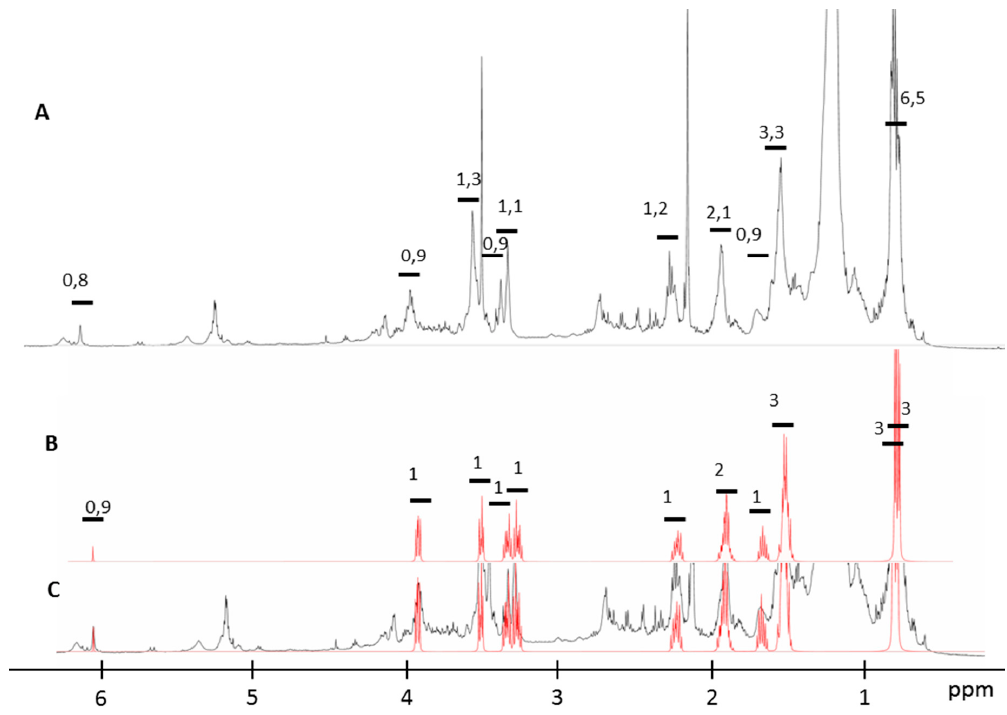
Figure 2. ( A ) 1 H NMR spectrum of the biological active fraction, ( B ) 1 H NMR spectrum of The synthetic cyclo-(L-pro-L-leu) and ( C ) superposition of ( A ) identified cyclo-(L-pro-L-leu) in the biological fraction with the NMR spectra of ( B ) the synthetic cyclo-(L-pro-L-leu).